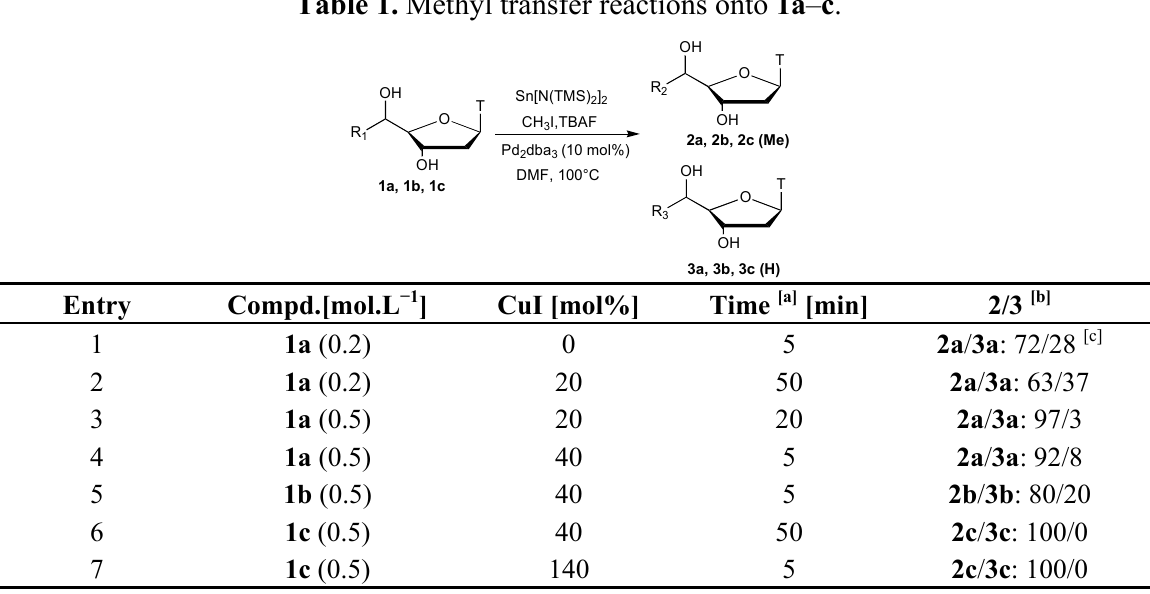
Table 1. Methyl transfer reactions onto 1a ‒ c